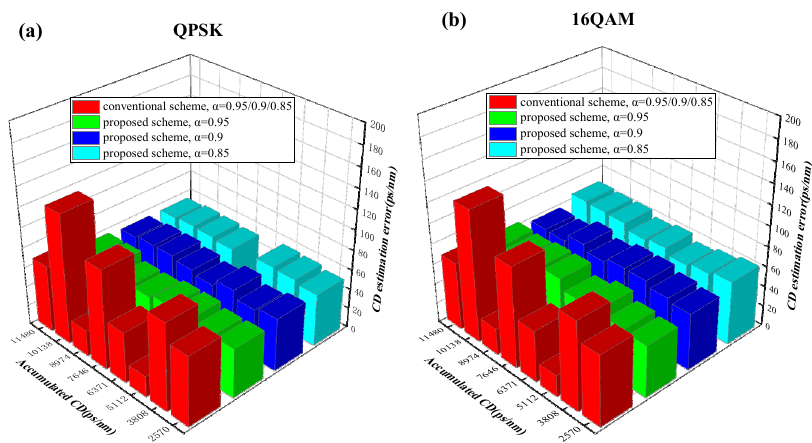
Figure 11. ( a ) The mean value of the absolute CDE error in ( a ) DP-QPSK and ( b ) DP-16QAM sys- tems.